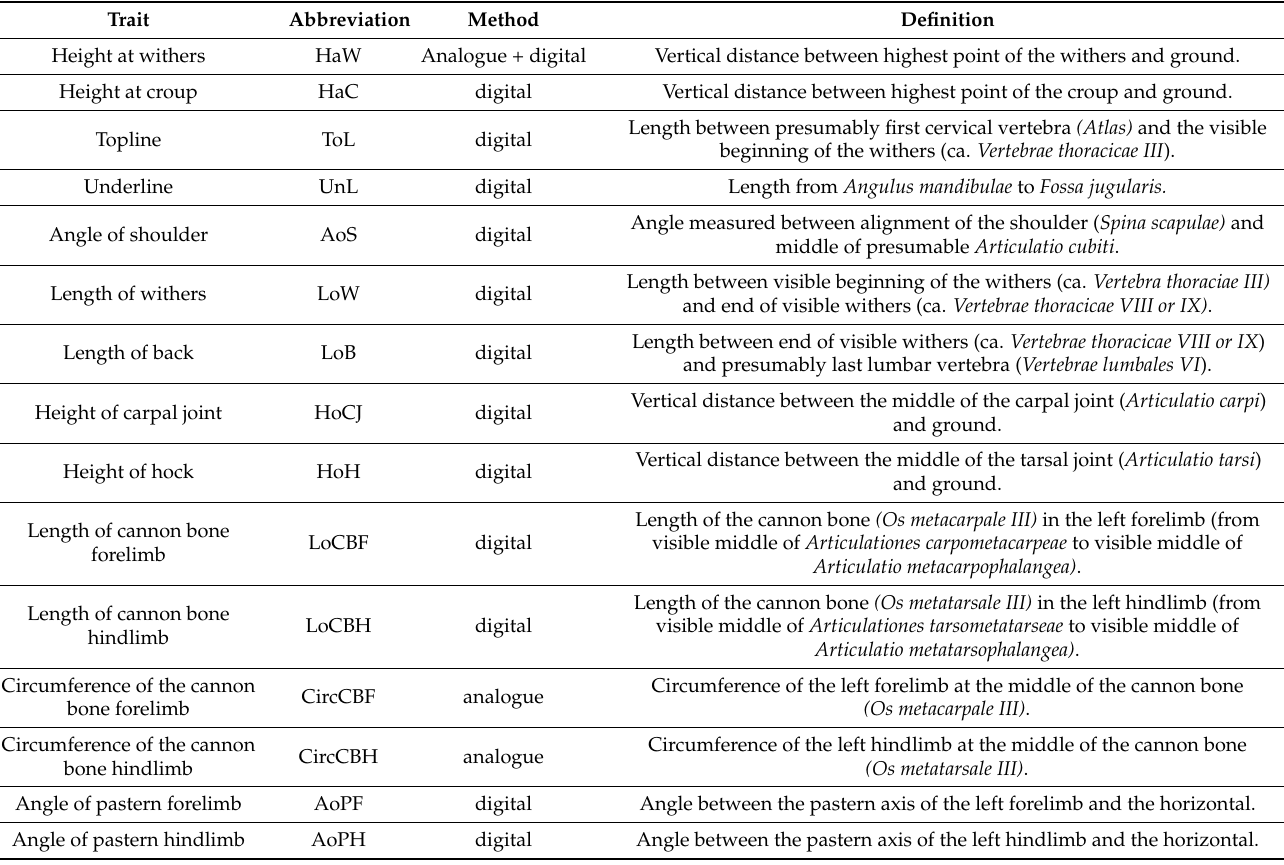
Table 1. Definition of the analogically and photometrically measured traits, with